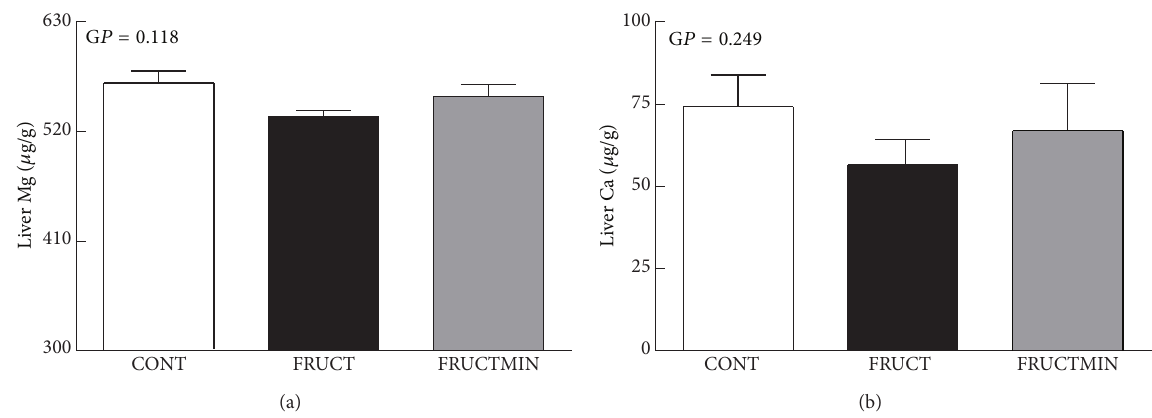
Figure 8: Liver magnesium (a) and calcium (b) content ( 𝜇 g/g of tissue lyophilize; 𝑛 = 6 for both elements), at the end of the dietary intervention. Results were expressed as mean ± standard error of the mean. Ca: calcium; CONT: control; FRUCT: 10% fructose in tap water; FRUCTMIN: 10% fructose in natural mineral-rich water; G 𝑃 : global P ; Mg: